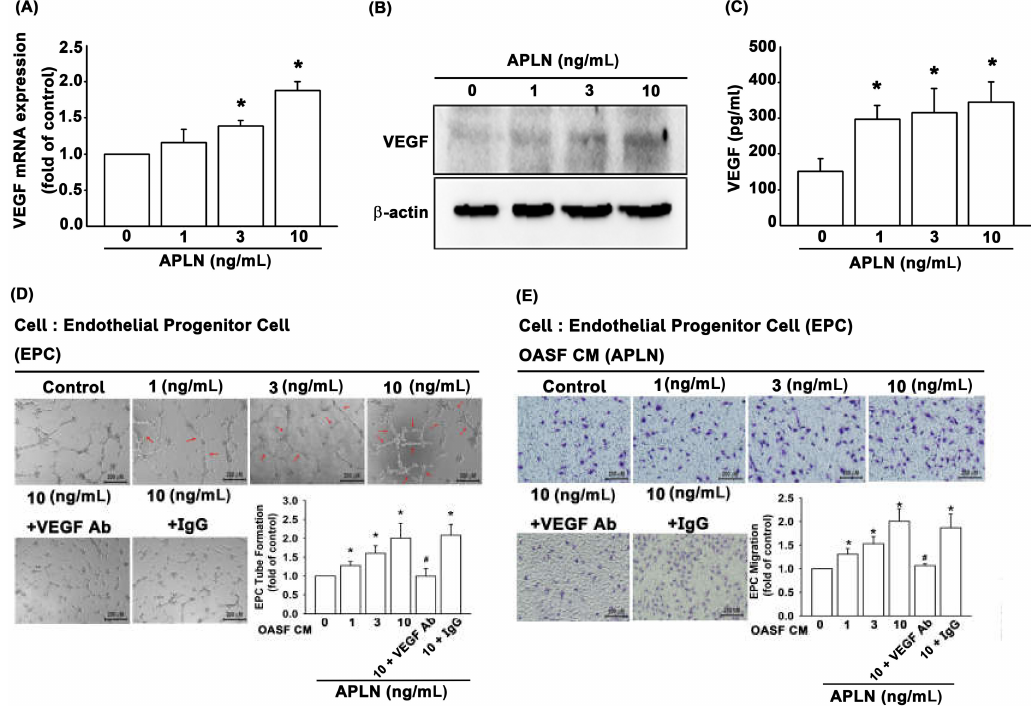
Figure 2. APLN stimulates VEGF expression and angiogenesis capacity in osteoarthritis synovial fibroblasts (OASFs). ( A ) APLN (0, 1, 3, or 10 ng / mL) was administered to OASFs for 24 h, and the extent of VEGF transcription was examined using real-time quantitative PCR (RT-qPCR) ( n = 4). ( B ) OASFs were incubated under various APLN concentrations for 24 h, and VEGF translation levels were examined using Western blot ( n = 3). ( C ) OASFs were cultured with APLN for 24 h, and excreted VEGF protein levels were assayed using ELISA assay ( n = 5). The culture medium was subsequently collected, and culture medium from OASFs incubated with APLN was further treated with VEGF antibody and IgG. All culture medium (with and without VEGF / IgG antibody treatment) were subjected to endothelial progenitor cell (EPC) tube formation ( n = 5) ( D ) and EPC migration ( E ) assays ( n = 5). * p < 0.05 compared with control; # p < 0.05 compared with the APLN-treated